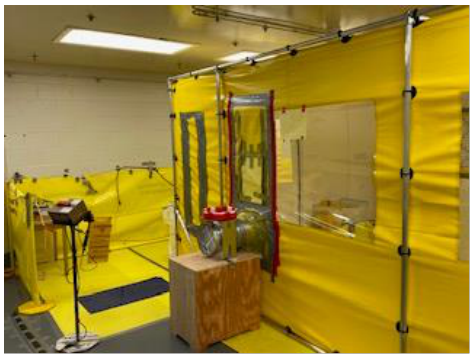
Figure 4. Radiological Containment Tent.